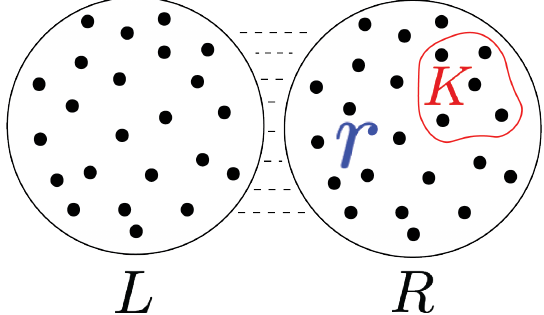
Figure 1. We imagine that we have a system of qubits prepared in their thermo-field double state, whose entanglement is represented by the dashed lines. We will ask the question of what is the largest number of qubits, K , from the right that we can give to the left such that we can just reconstruct an excitation on r = LK